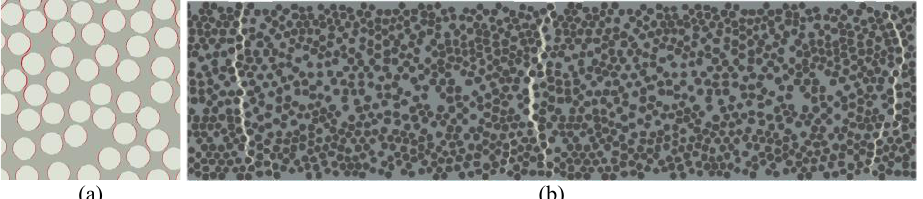
Fig. 2. Initial fibre-matrix interface damage (a) and transverse matrix cracks